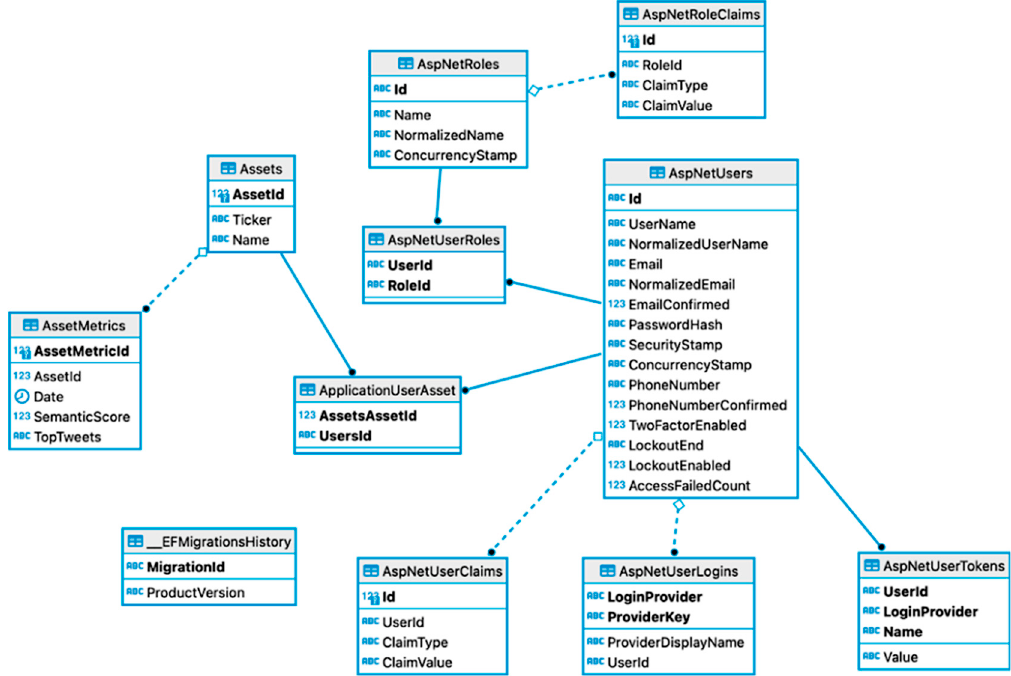
Figure 14. ER Diagram—Database Schema.